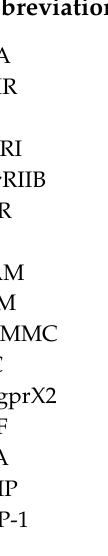
Figure 5. Conclusions. Figure 5.